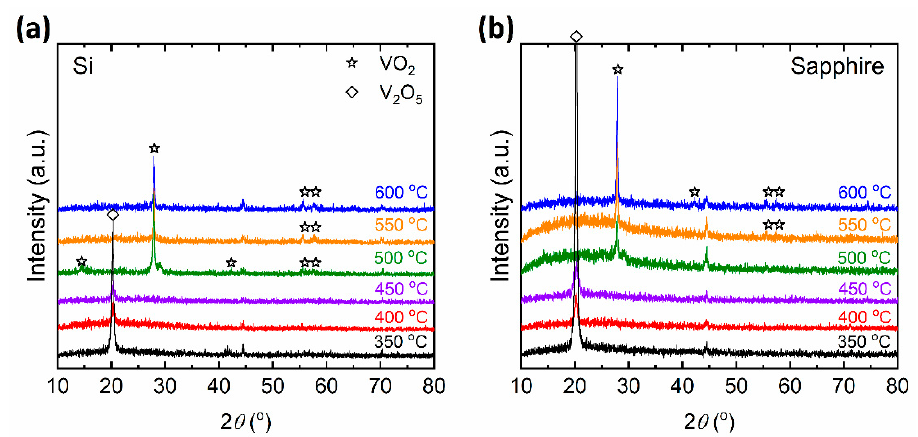
Figure 2. XRD spectra of VO 2 and V 2 O 5 thin films prepared at various substrate temperatures ( T S ) on ( a ) Si and ( b ) sapphire substrates. Note that the vertical axes are in arbitrary units (a.u.).